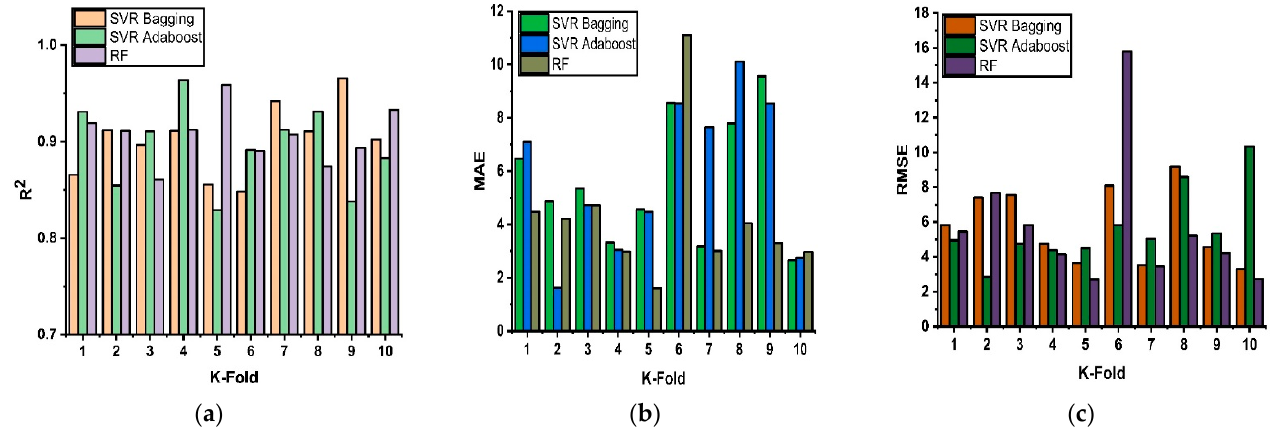
Figure 6. ( a ) Regression results (R 2 ) of models with 10 k-fold cross-validations of models; ( b ) MAE Statistical error results of models with 10-K fold cross- validation; ( c ) RMSE Statistical error results of models with 10-k fold cross- validation.